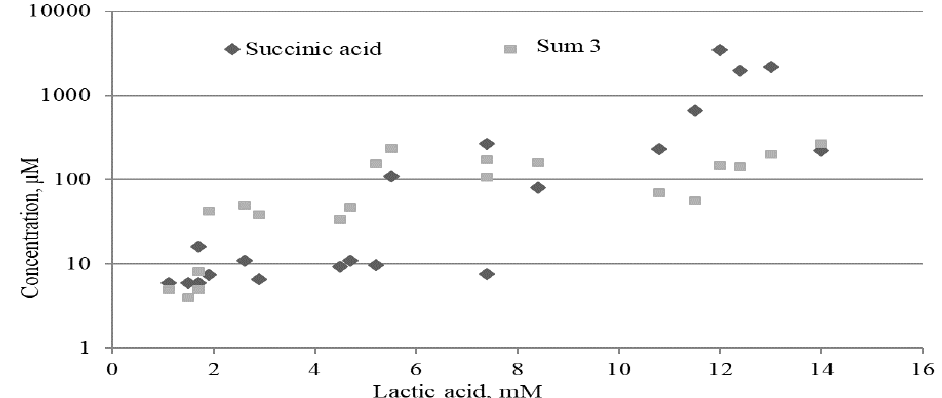
Figure 3. Comparison of concentrations of mitochondrial and microbial metabolites in relation to lactate levels obtained in the serum samples of the patients with late-stage sepsis in Group II ( n = 22). The concentrations of three PhCAs and succinic acid are shown on a log scale with a base of 10.